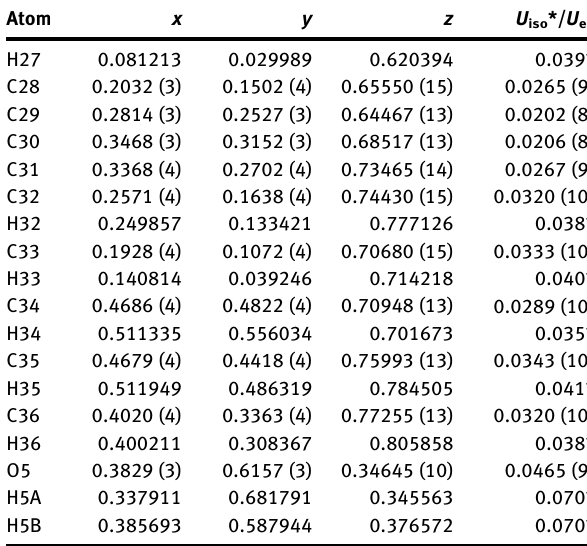
Table  : Fractional atomic coordinates and isotropic or equivalent isotropic displacement parameters (Å 